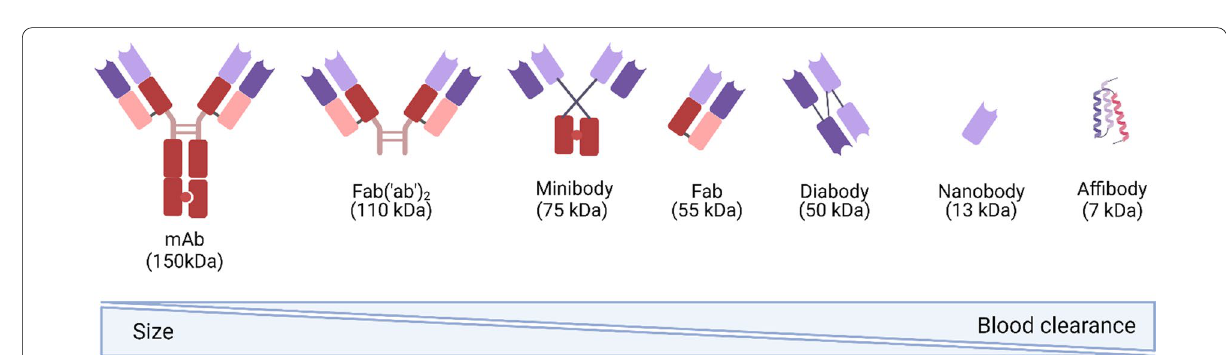
Fig. 2 Protein-based constructs used for ImmunoPET and T-cell tracking. This panel points out how the molecular weight (MW) of the different antibody- and peptide-derived probes influence their blood pool clearance, which influences the selection of the right radioisotope for